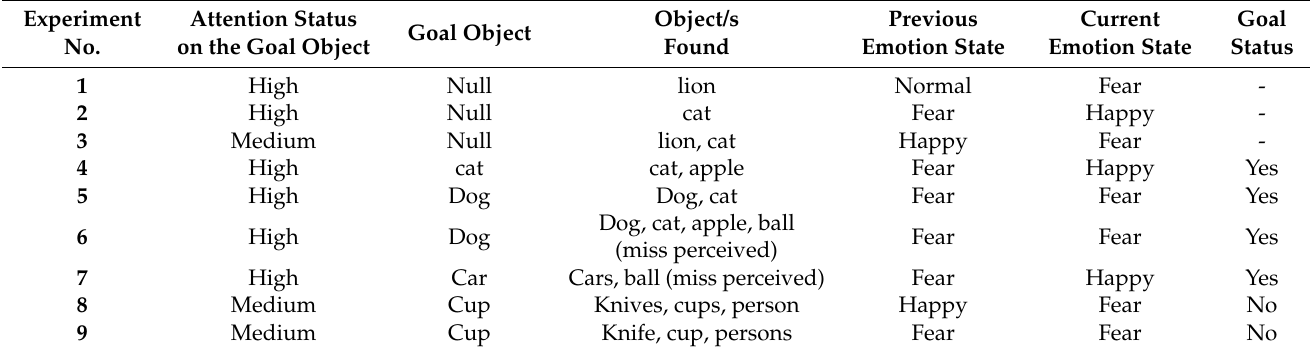
Table 7. This table represents the summary of experiments (attention with emotions). This table